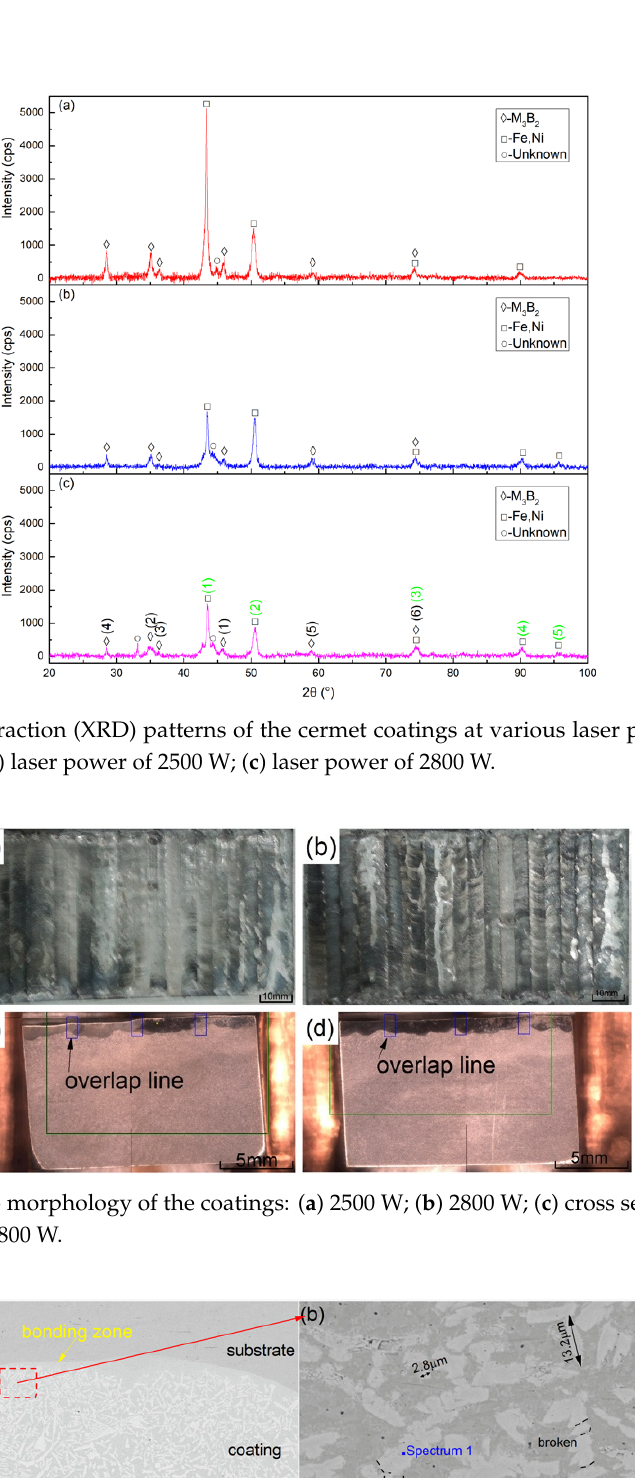
Figure 4. Scanning electron microscopy (SEM) morphology of the cermet coatings at 2200 W: ( a ) low magnification; ( b ) high magnification.